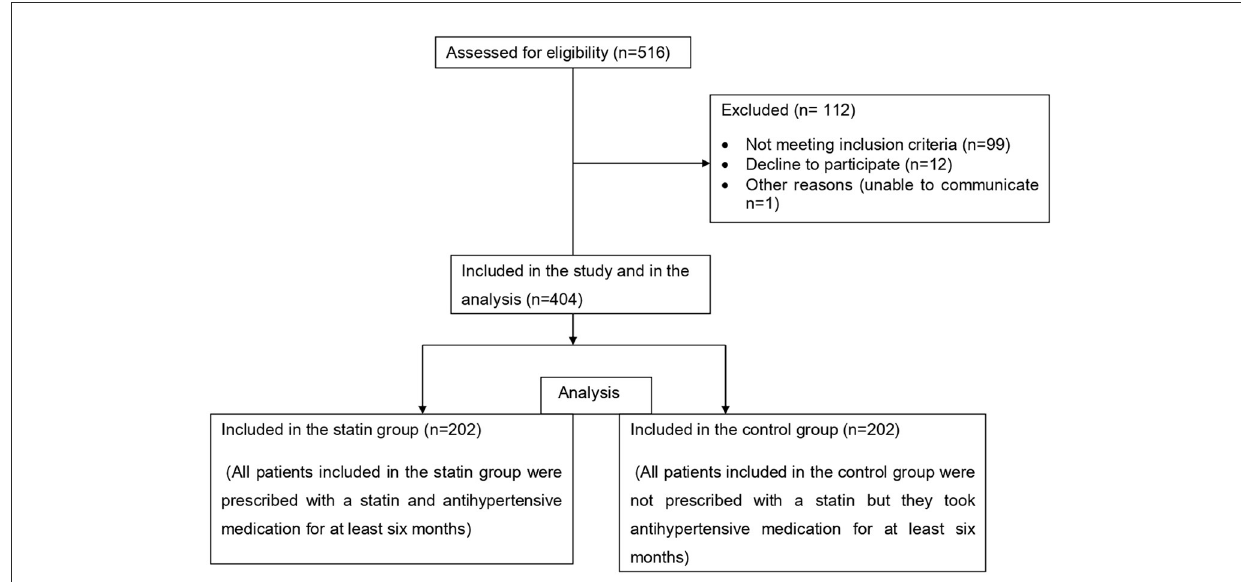
FIGURE1 Participants’ enrolment flowchart of patients with hypertension attending outpatient clinic at the Felege Hiwot Comprehensive and Specialized Hospital, northwest Ethiopia.